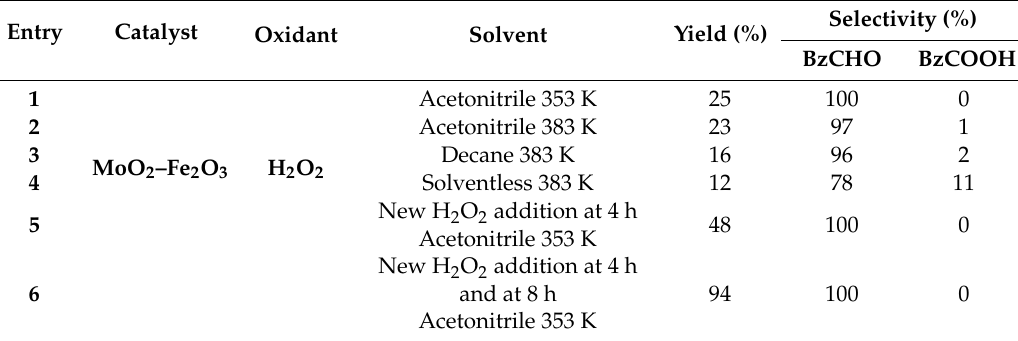
Table 3. Results from benzyl alcohol oxidation with H 2 O 2 as the